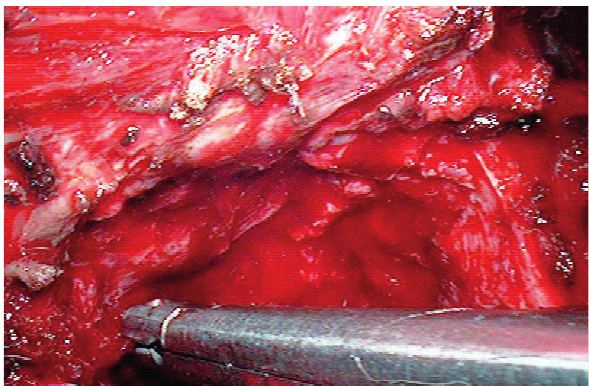
Fig. 3. OP view where dural sac is released and decompressed with ronquer.